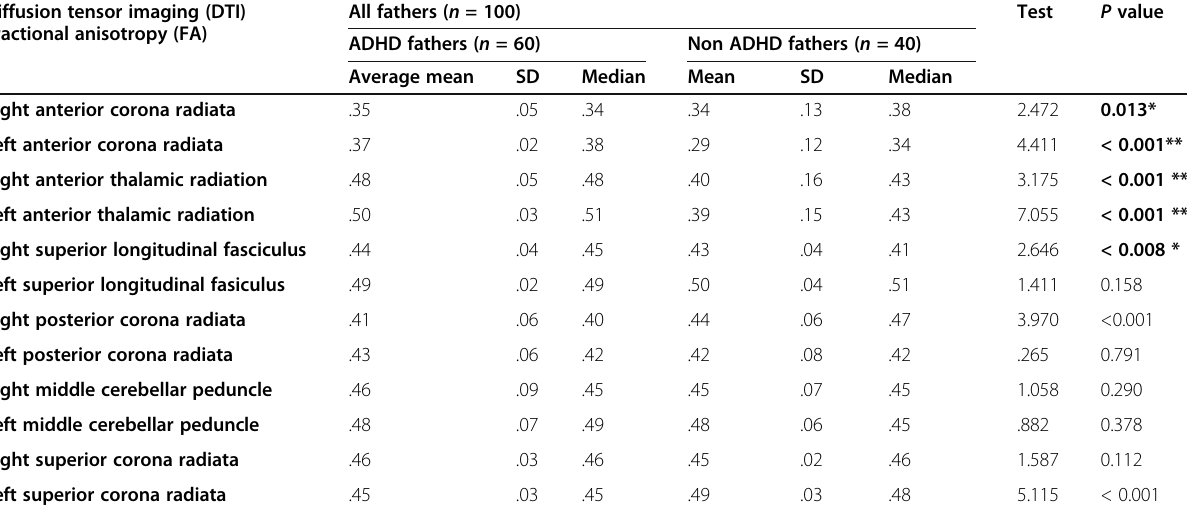
Table 2 Comparison between fathers with the diagnosis of potential adult ADHD vs. those without potential adult ADHD as regards to findings of DTI